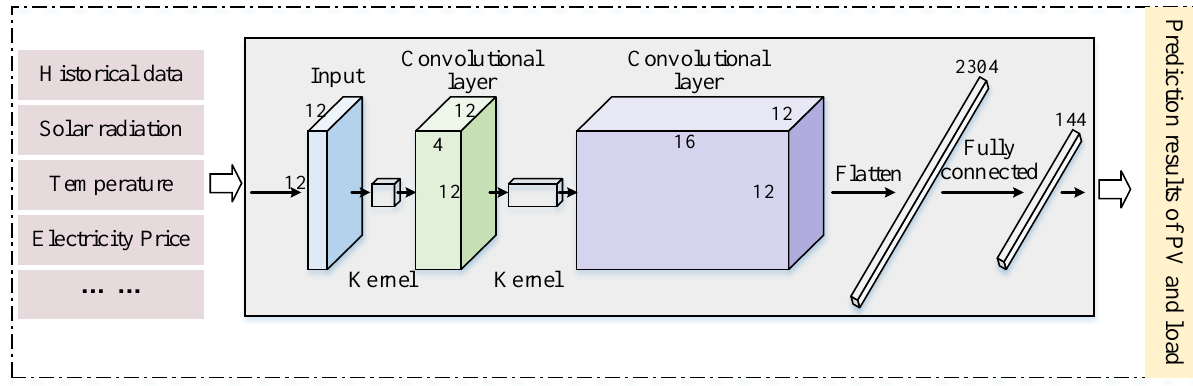
Figure 3. CNN-based prediction model for PV generation and load.